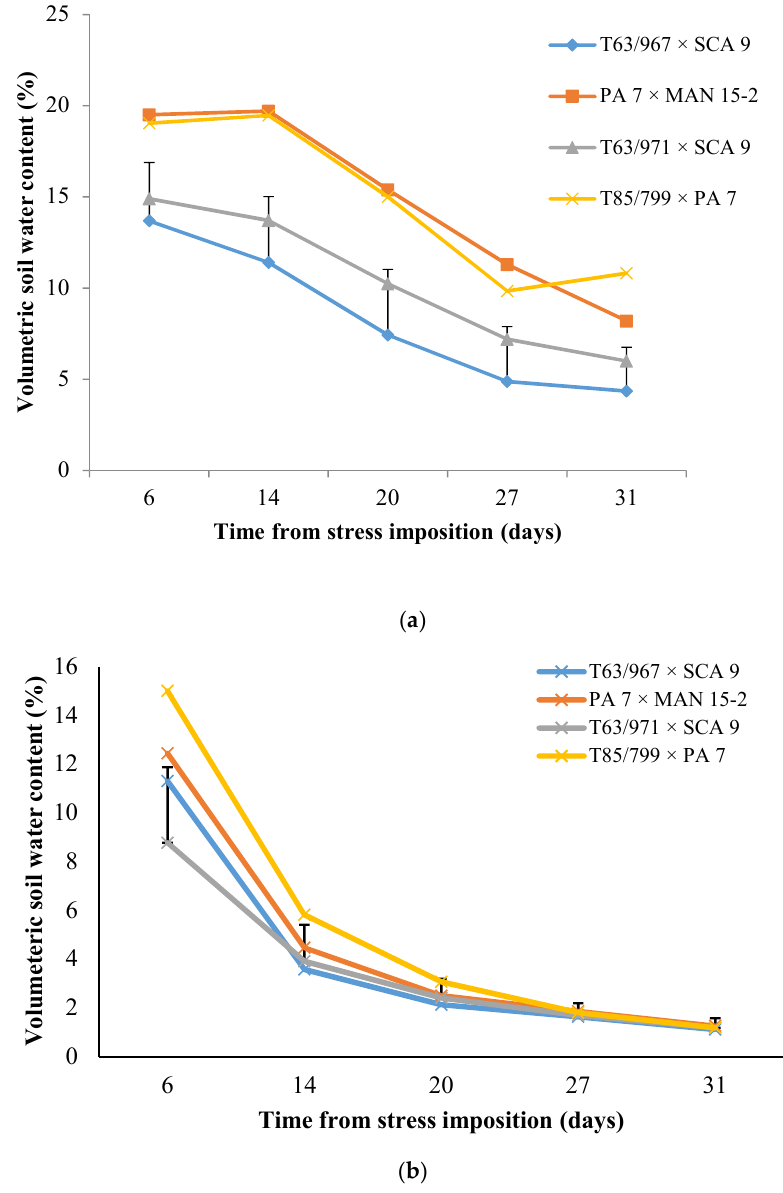
Figure 2. Changes in volumetric soil water contents under four cocoa varieties in ( a ) well-watered and ( b ) water-stressed treatments in a gauzehouse facility. In well-watered treatments, measurements were done prior to watering plants to field capacity. Bars represent the LSD value for comparing varieties at each sampling